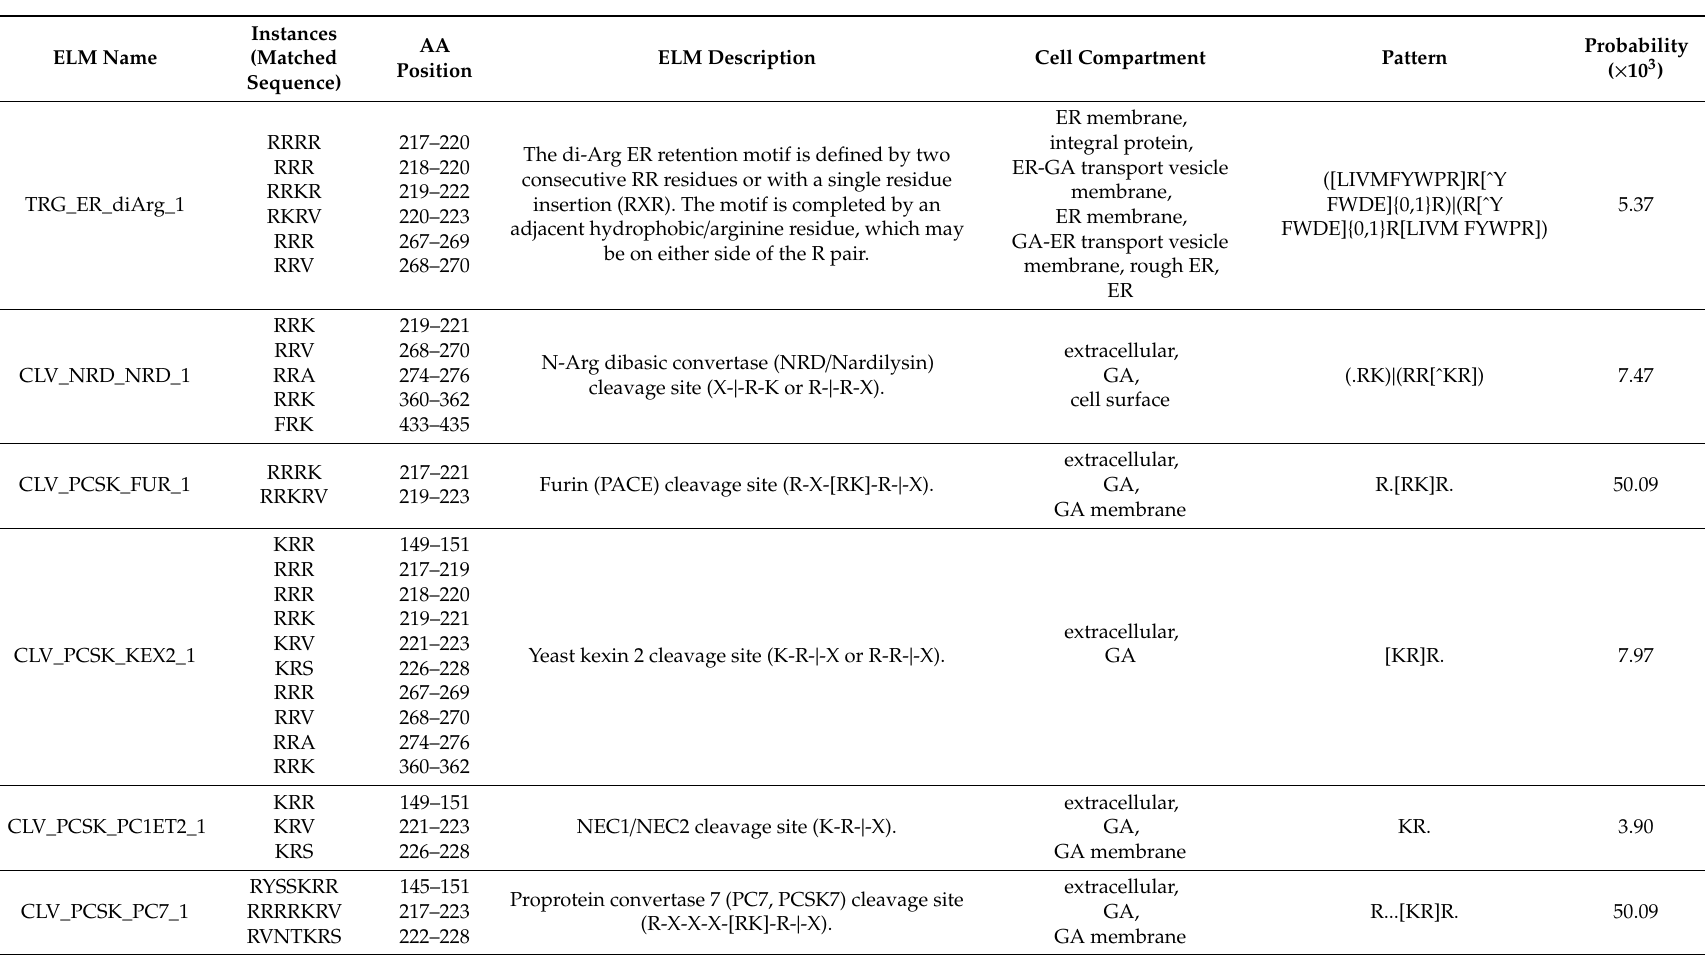
Table 1. Motifs obtained from eukaryotic linear motif (ELM) bioinformatics analysis of type 2 dopamine receptor D 2 (D 2 -R)